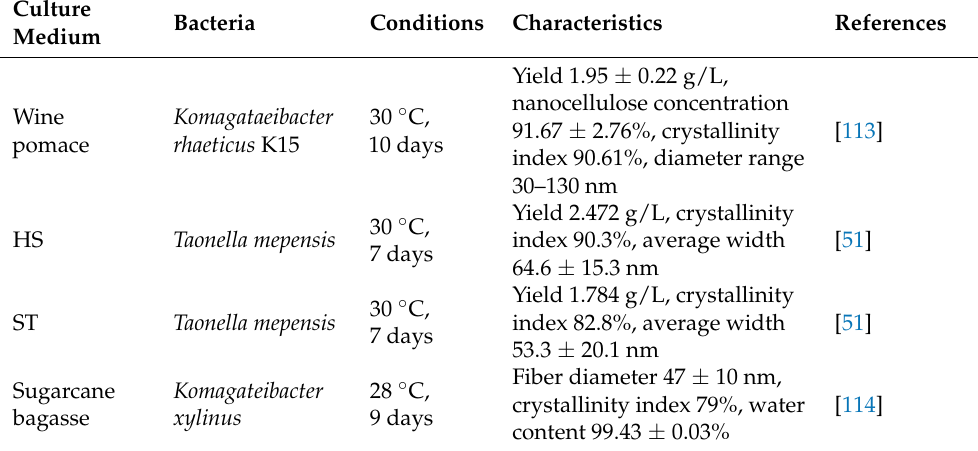
Table 3. Methods for the preparation of